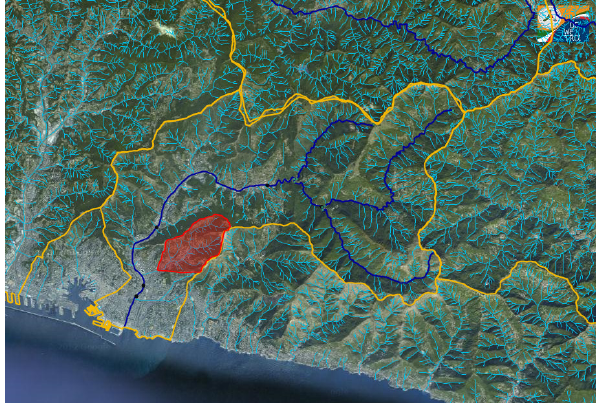
Figure 5. Bisagno creek (blue line and yellow watershed, Area=90 km 2 ) and its tributary 3 Fig. 5. Bisagno creek (blue line and yellow watershed, Area = Fereggiano brook (red area, Area=4.5 km 2 ). 4 90km 2 ) and its tributary Fereggiano brook (red area, Area = 4.5km 2 ) .